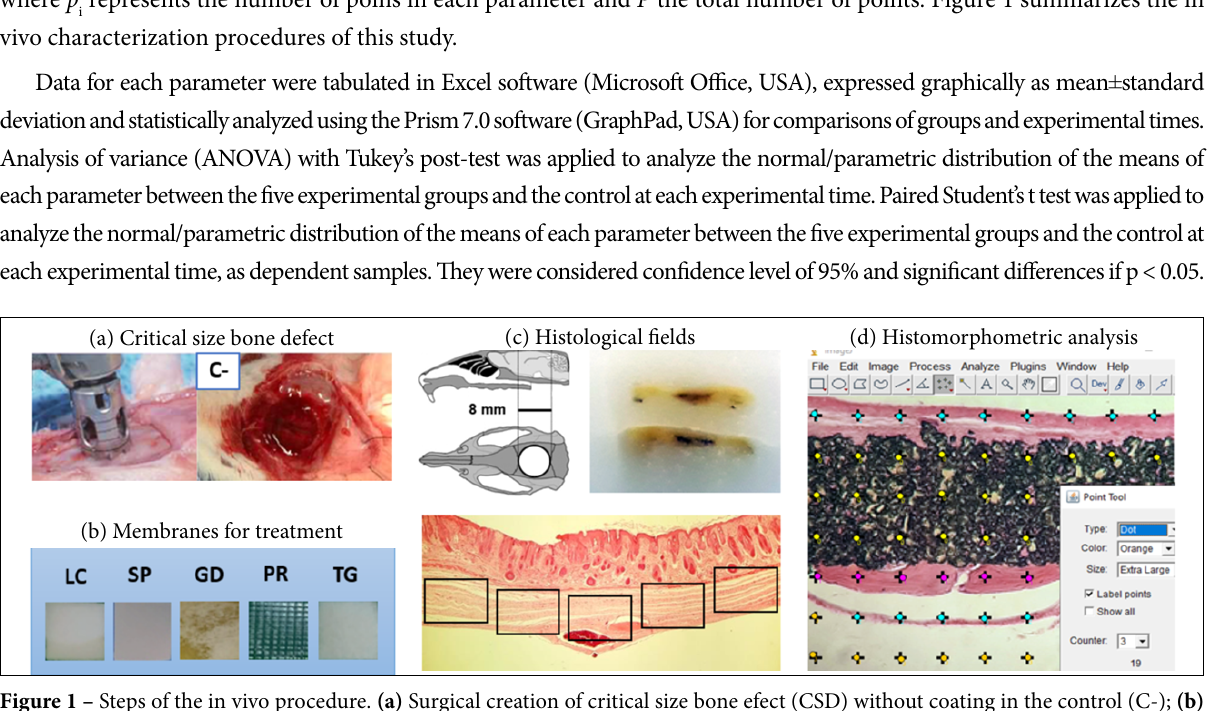
Figure 1 – Steps of the in vivo procedure. (a) Surgical creation of critical size bone efect (CSD) without coating in the control (C-); (b) Membranes for treatment: LuminaCoat (LC), Surgitime PTFE (SP), GenDerm (GD), Pratix (PR) or TechGraft (TG); (c) After cleavage of the samples and processing in paraffin, 5 fields were photocaptured per histological slide along the CSD; (d) Histomorphometric analysis by points using ImageJ software, with different biological criteria distinguished by